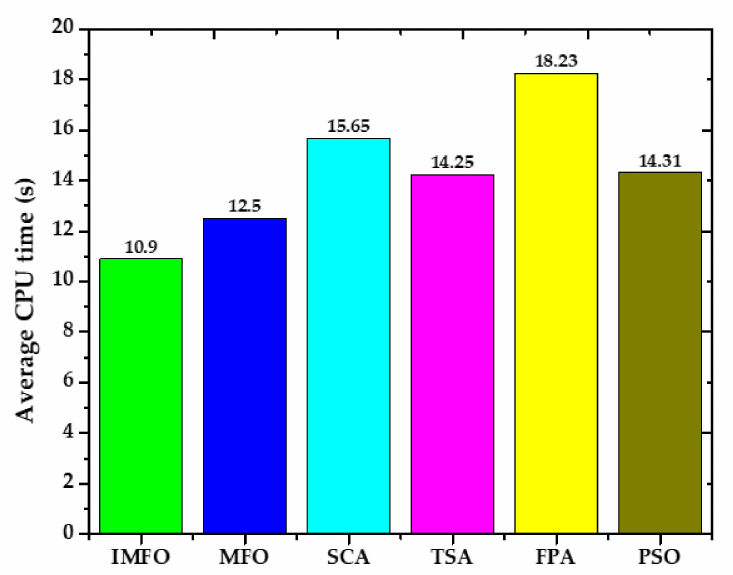
Figure 7. An evaluation of computational time for different